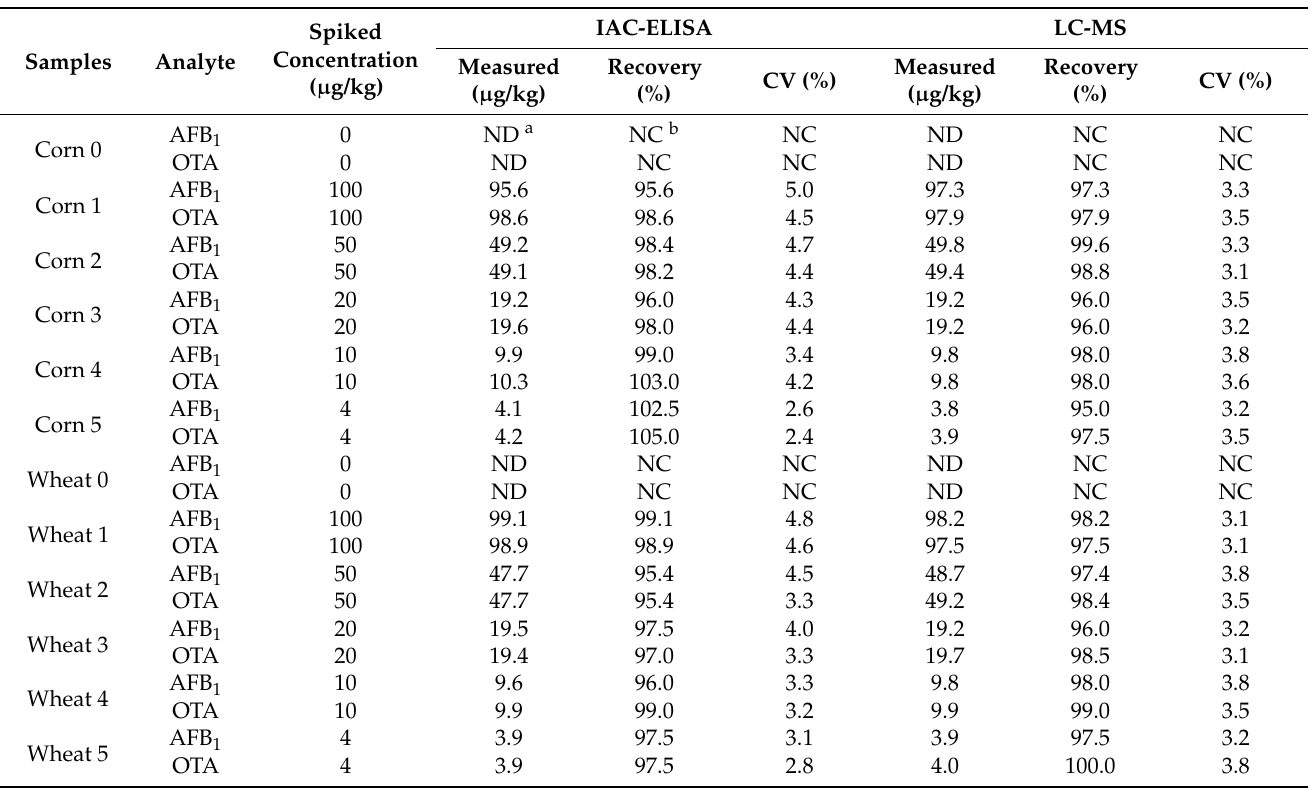
Table 4. Results of spiked recovery experiments of corn and wheat samples with IAC-ELISA and LC-MS ( n =